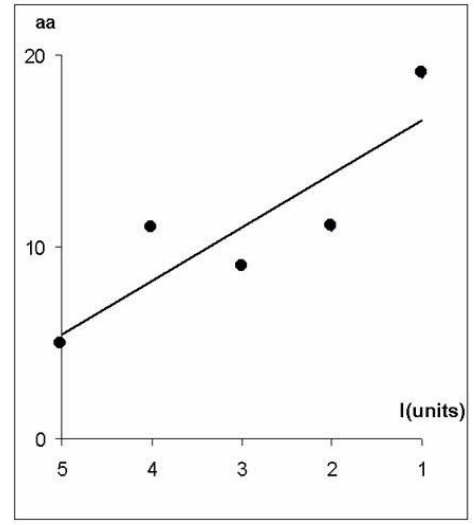
Fig. 9. The dependence of auroral intensity on planetary geomag- Figure 9. The dependence of auroral intensity on planetary geomagnetic activity at netic activity at Spitsbergen for two winter months of Spitsbergen for two winter months of 1899.